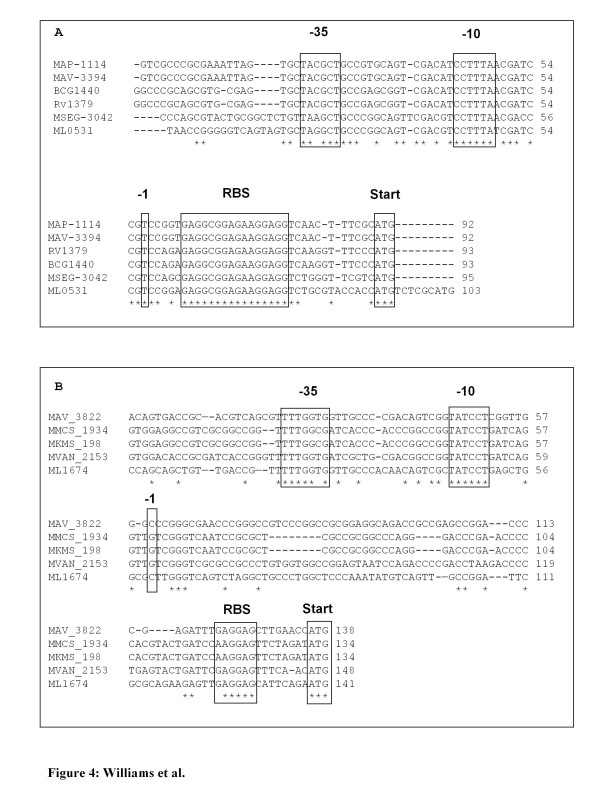
Promoter-like sequences upstream of transcribed M. leprae pseudogenes. This figure shows representative alignments of promoter-like sequences for M. leprae pseudogenes and their mycobacterial homologs. Panel A & B represent the pyrR (ML0531) and rpmB (ML1674) upstream promoter-like regions containing -35 and -10 regions and initiation site (I) in relationship to their ribosomal binding sites (RBS) and translational start codons (Start), respectively. * indicates identical nucleic acids in all strains. Mycobacterial species abbreviations : MAP-Mycobacterium avium, subsp paratuberculosis K-10. MAV-Mycobacterium avium 104. BCG-Mycobacterium bovis BCG Pasteur 1173P2. RV-Mycobacterium tuberculosis H37Rv. MSEG-Mycobacterium smegmatis MC2 155. ML-Mycobacterium leprae TN. MMCS-Mycobacterium MCS. MKMS-Mycobacterium KMS. MVAN-Mycobacterium vanbaalenii PYR-1